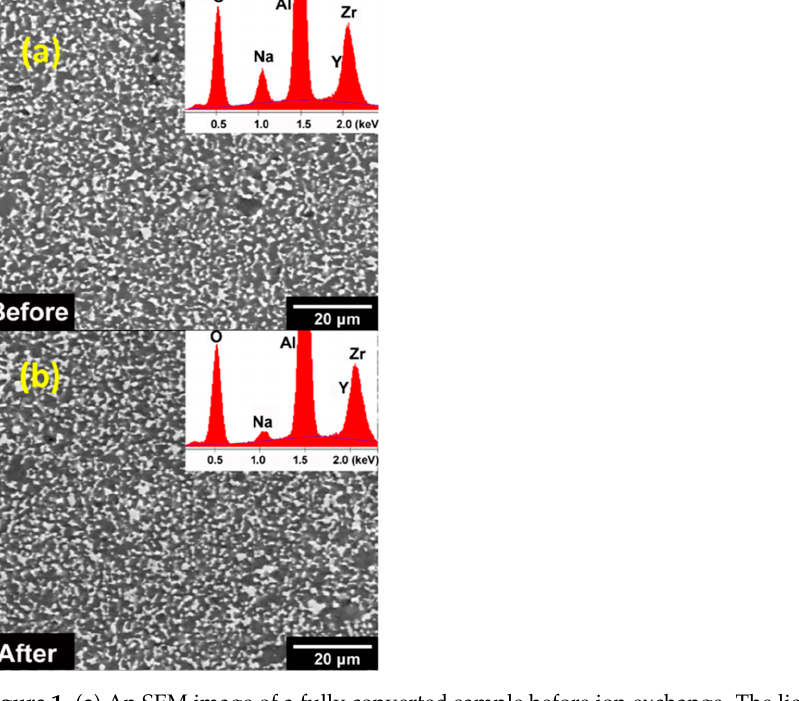
Figure 1. ( a ) An SEM image of a fully converted sample before ion exchange. The light areas are YSZ and the dark areas are Na- β″ -alumina. The sample exhibits high density (negligible porosity) and fine microstructure. The EDS spectrum shows peaks corresponding to O, Na, Al, Zr and Y. ( b ) An SEM image of the sample after ion exchange in LiNO 3 at 370 °C for 24 h. The microstructure is virtually unchanged. The EDS spectrum shows peaks corresponding to O, Na, Al, Zr and Y. The intensity of the Na peak is much lower in the ion-exchanged sample consistent with its partial replacement by